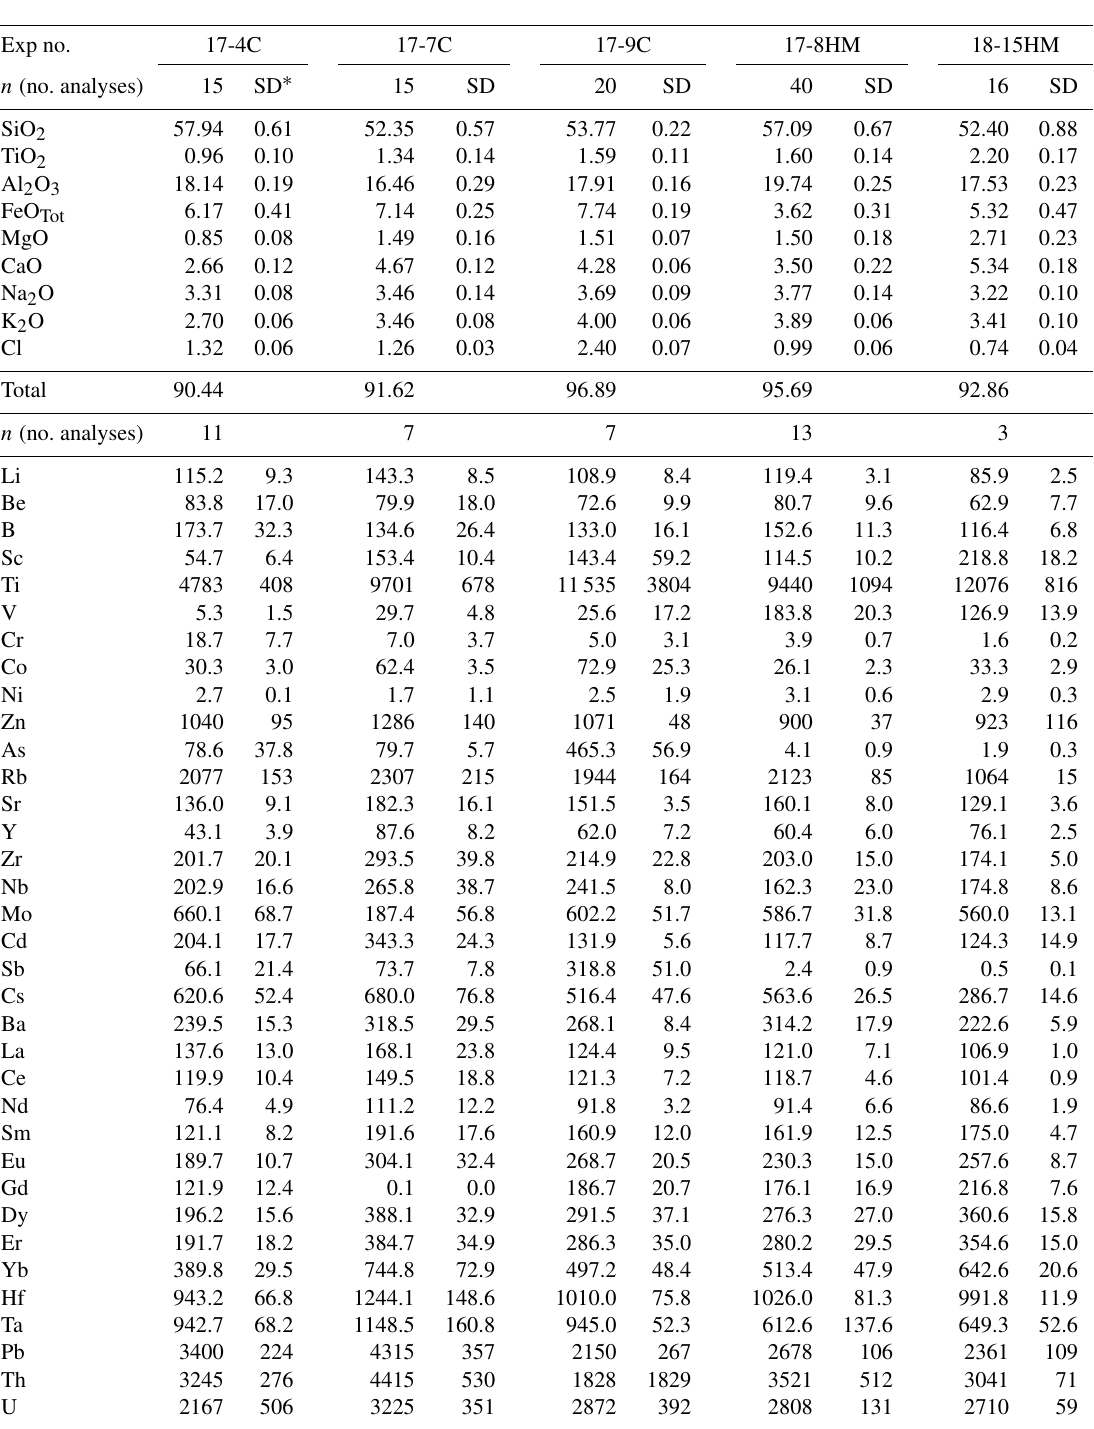
Table 3. Glass compositions (major elements in wt% and trace elements in µg / g). Exp